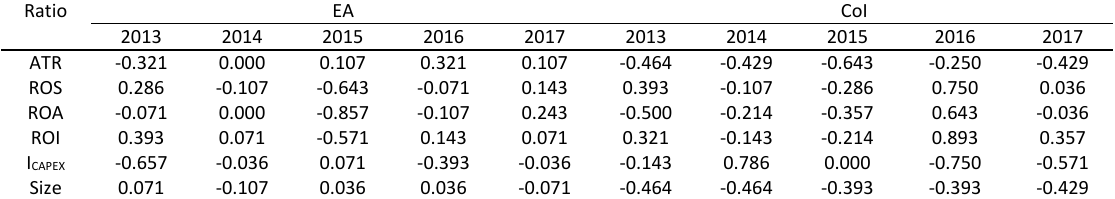
Table 7: Spearman’s ranks correlation coefficient for economic and environmental ratios in 2013-2017 Ratio EA CoI ATR -0.321